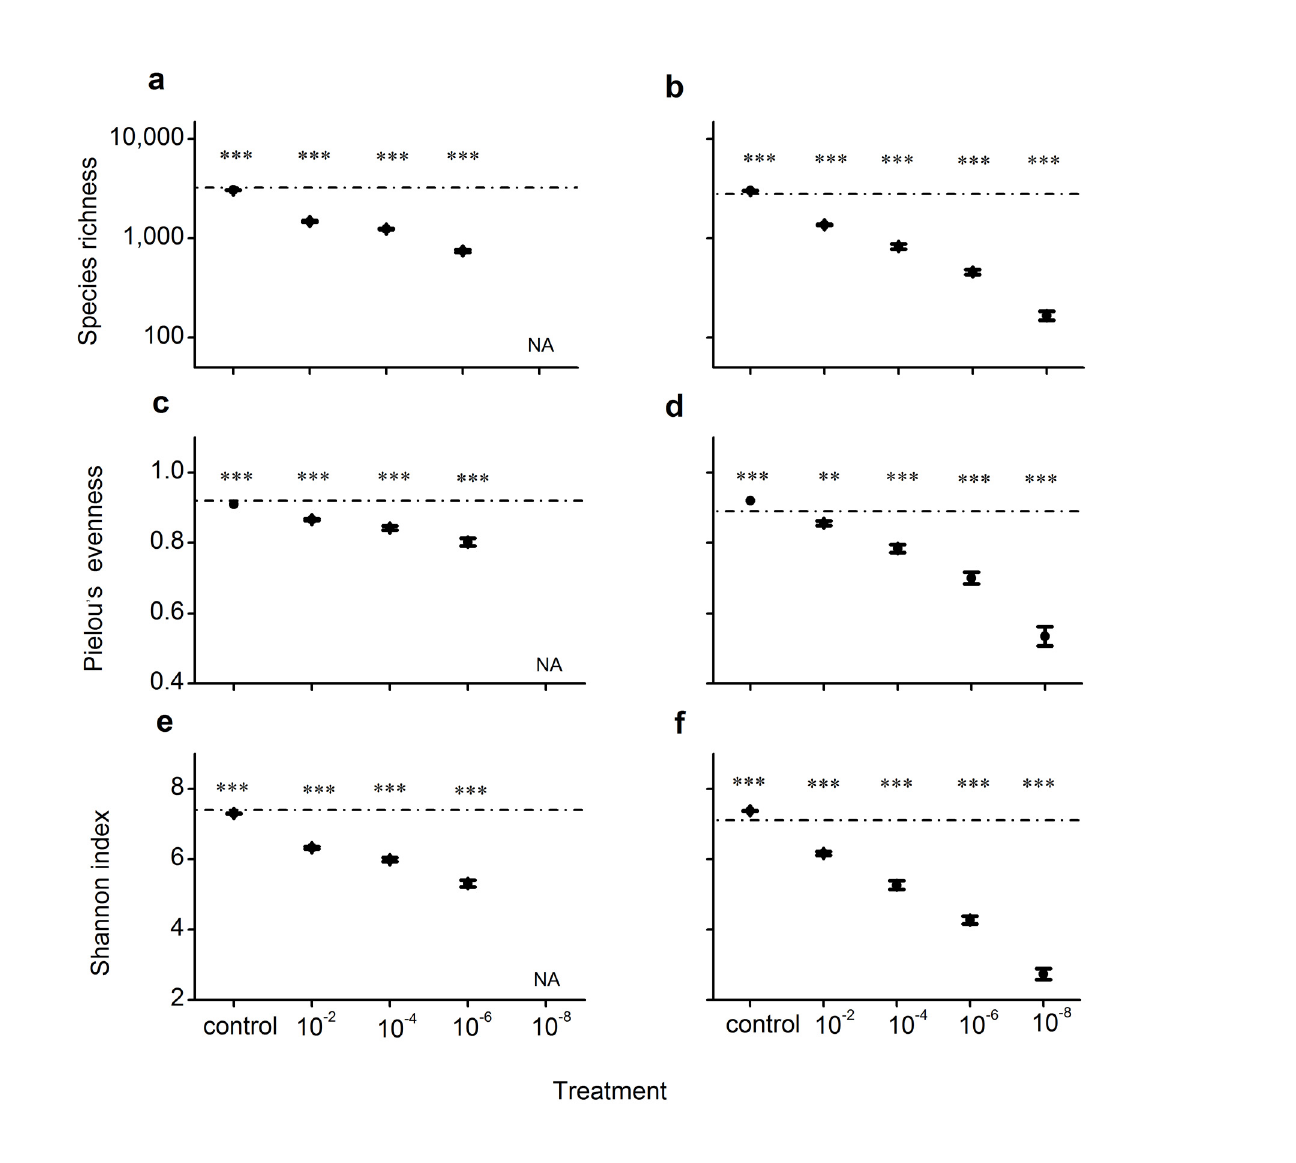
Fig 1. Species (OTUs) richness, Pielou ’ s eveness and Shannon index of bacterial communities. (a), (c) and (e ), the sandy soil microcosms. (b), (d) and (f ), the grassland soil microcosms. The horizontal lines represent the source soils. Asterisks indicate significant departure from the source soils (based on one-sample t test; single asterisk, p < 0.05; double, p < 0.01; triple, p < 0.001). Data show mean ± SE (n =